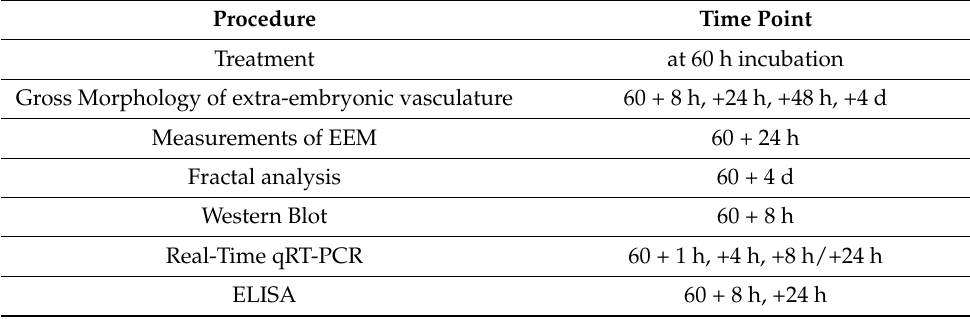
Table 1. Overview of procedures as described in Material and